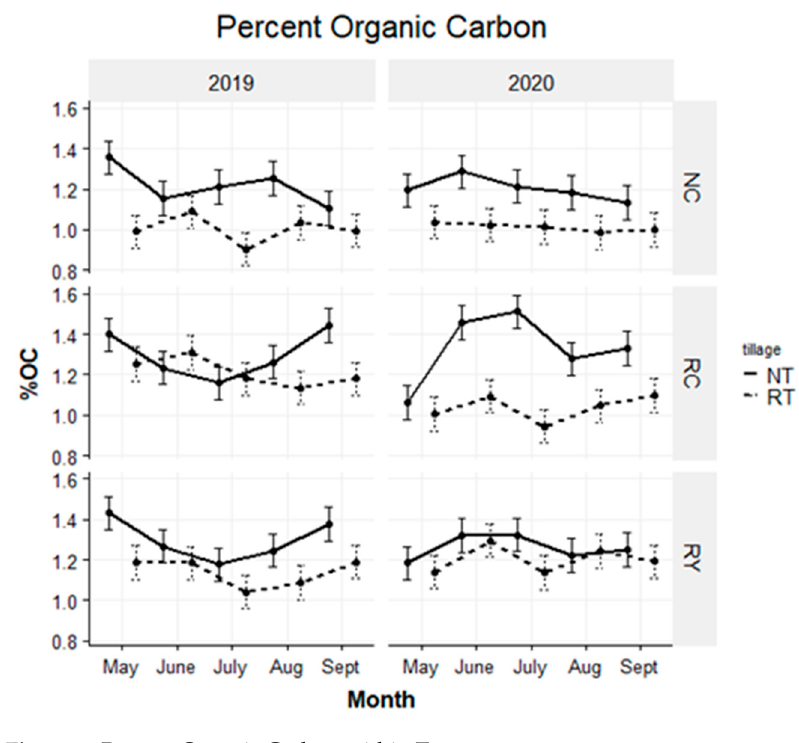
Figure 2. Percent Organic Carbon within Treatments.